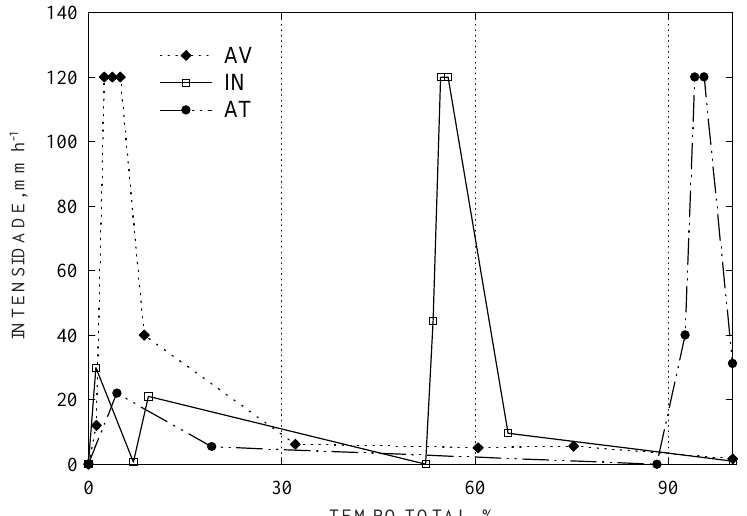
900 0 30 60 TEMPO TOTAL, Figura 1. Representação gráfica dos padrões de chuva avançado (AV), em 05 de novembro de 1963; intermediário (IN), em 16 de janeiro de 1972, e atrasado (AT), em 06 de janeiro de 1964.